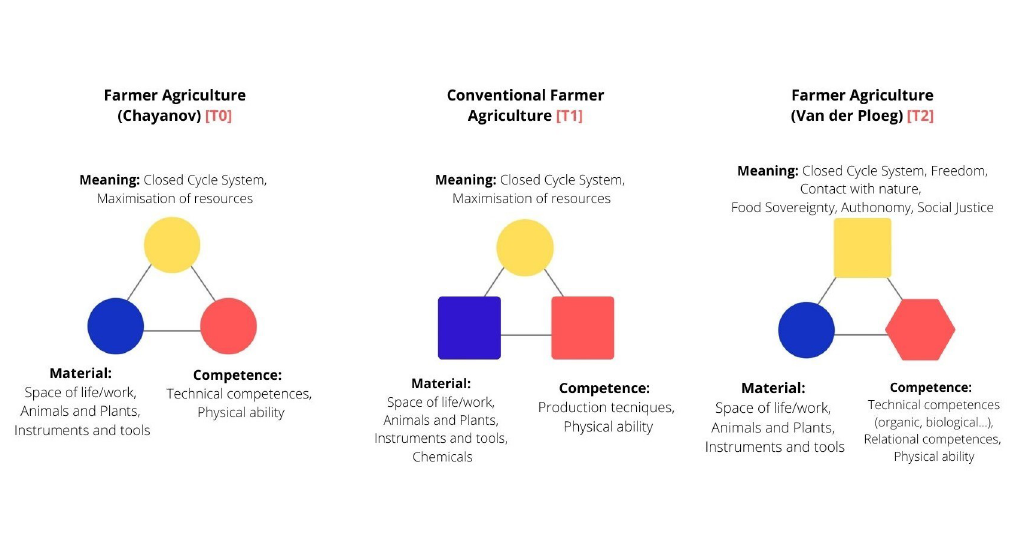
Fig. 8. The dynamic analysis of self-food production practice using the Theory of Practices by E.